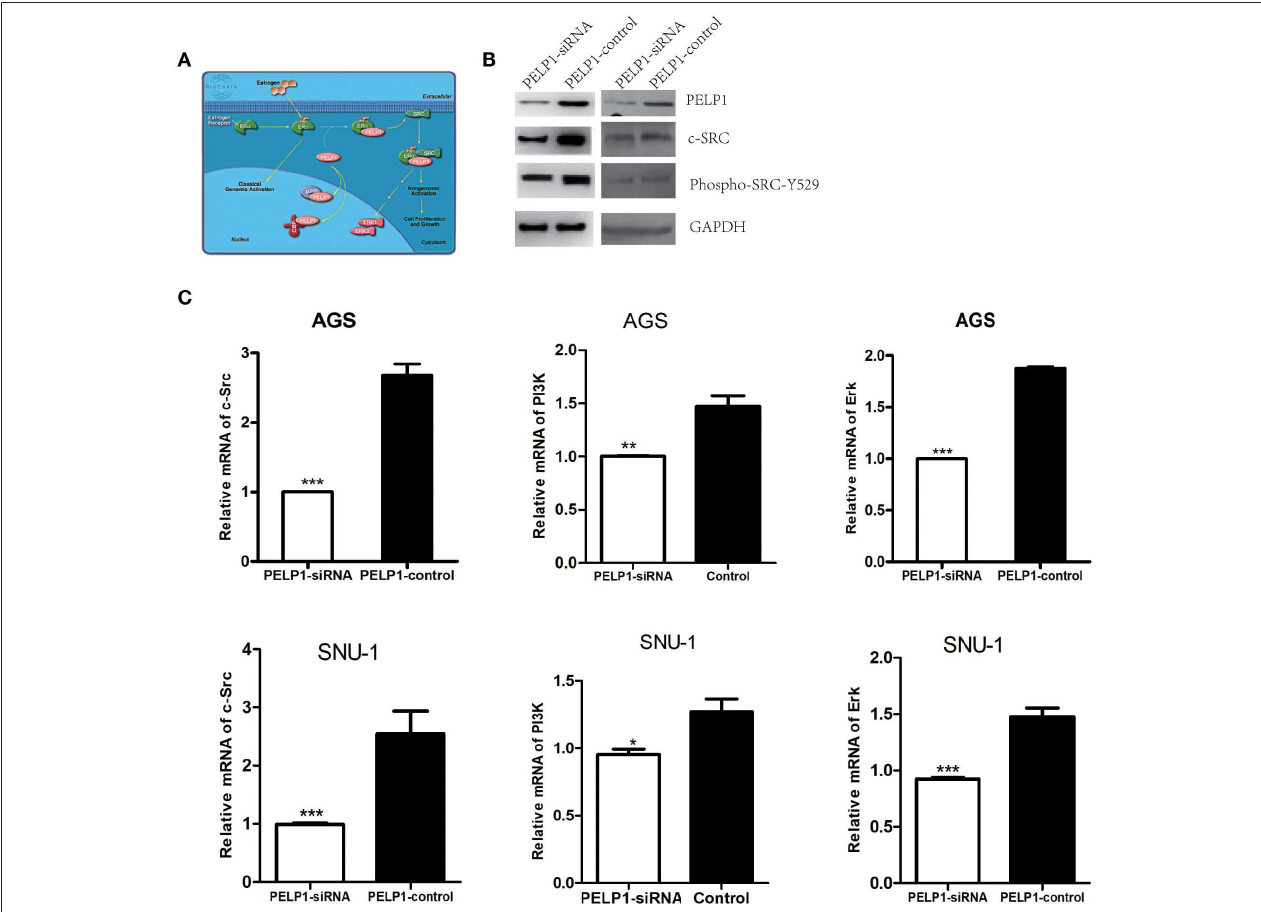
FIGURE 4 | PELP1 knockdown downregulated c-Src-PI3K-Erk pathway. (A) BIOCARTA analysis of PELP1 modulation of estrogen receptor activity in human pathway. AGS and SNU-1 cells were transfected with PELP1 siRNA or a non-targeting siRNA (control) for 48h. (B) PELP1 silencing was accompanied by downregulation of c-Src and decreased phospho-Src-Y529 protein as determined by western blot. (C) PELP1 silencing was accompanied by the downregulation of c-Src mRNA, PI3K mRNA and Erk mRNA as determined by quantitative RT-PCR. Values are the mean ± SEM (* p < 0.05, ** p < 0.01, *** p <